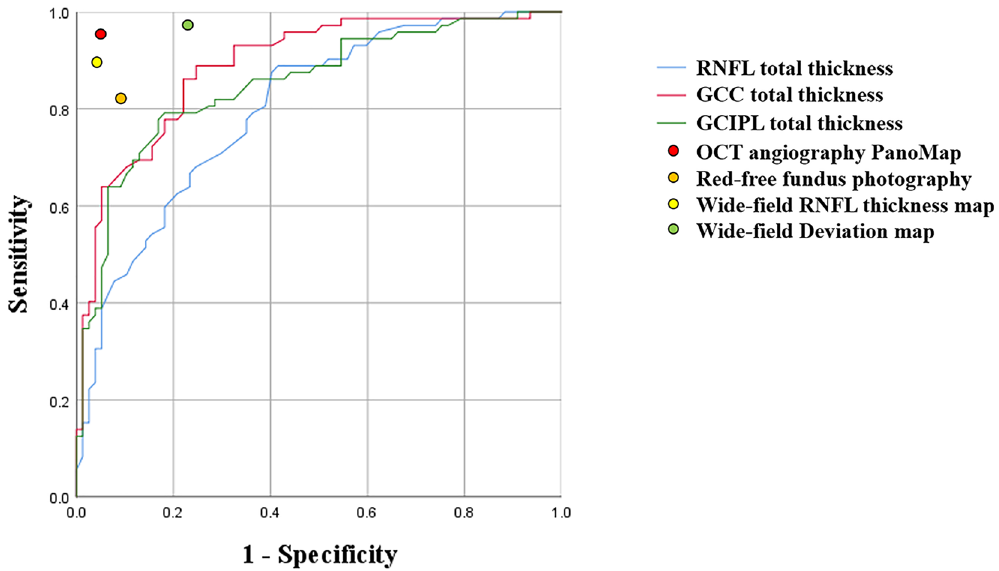
Figure 3. Comparison of the area under the receiver operating characteristic curves (AUCs) for discriminating between high myopic open angle glaucoma and healthy high myopia. AUC value of retinal nerve fiber layer (RNFL), ganglion cell complex (GCC), and ganglion cell-inner plexiform layer (GCIPL) thicknesses was 0.800, 0.889 and 0.852,